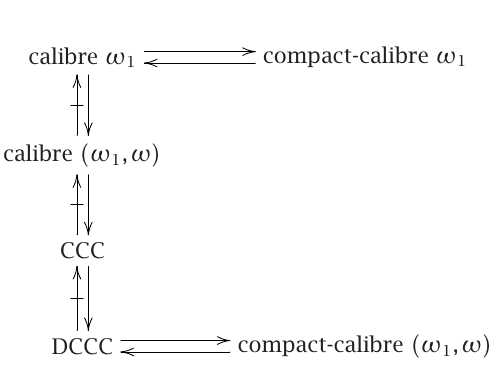
Figure 2.1 . Relative strengths of the conditions for Moore spaces and for spaces with point-countable